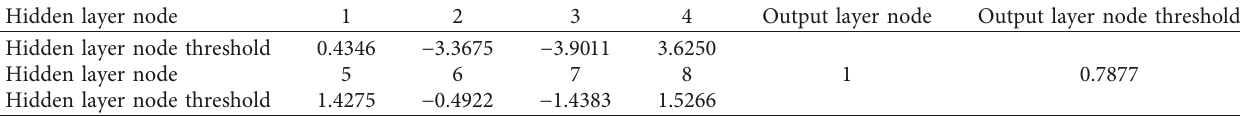
Table 2: Hidden layer and output layer node threshold table.